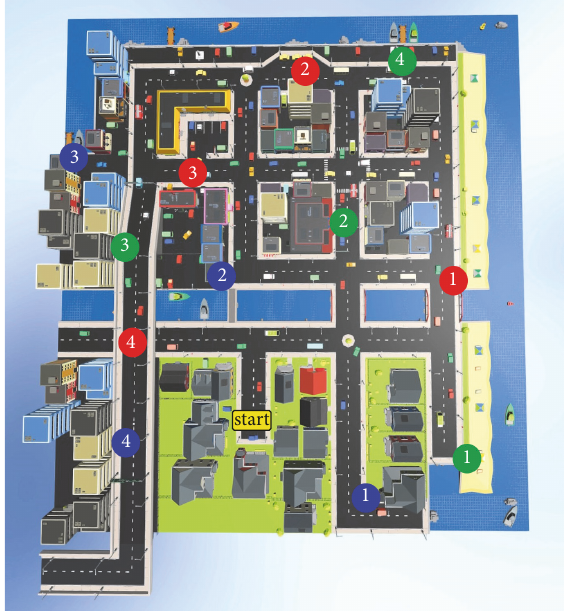
Figure 5: The checkpoints’ order for the three tasks (visualised in three different colours: red, green, and